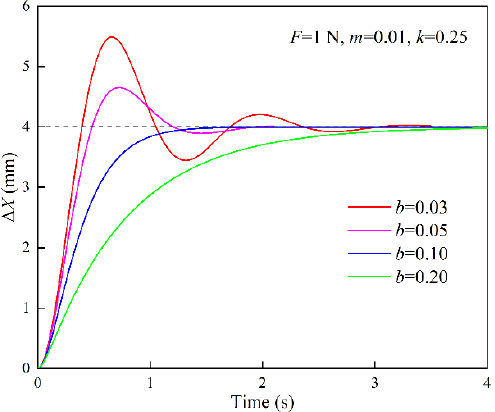
Figure 5. Response curves of position correction amount under different damping parameters ( m : N·s 2 /mm; b : N·s/mm; k : N/mm).